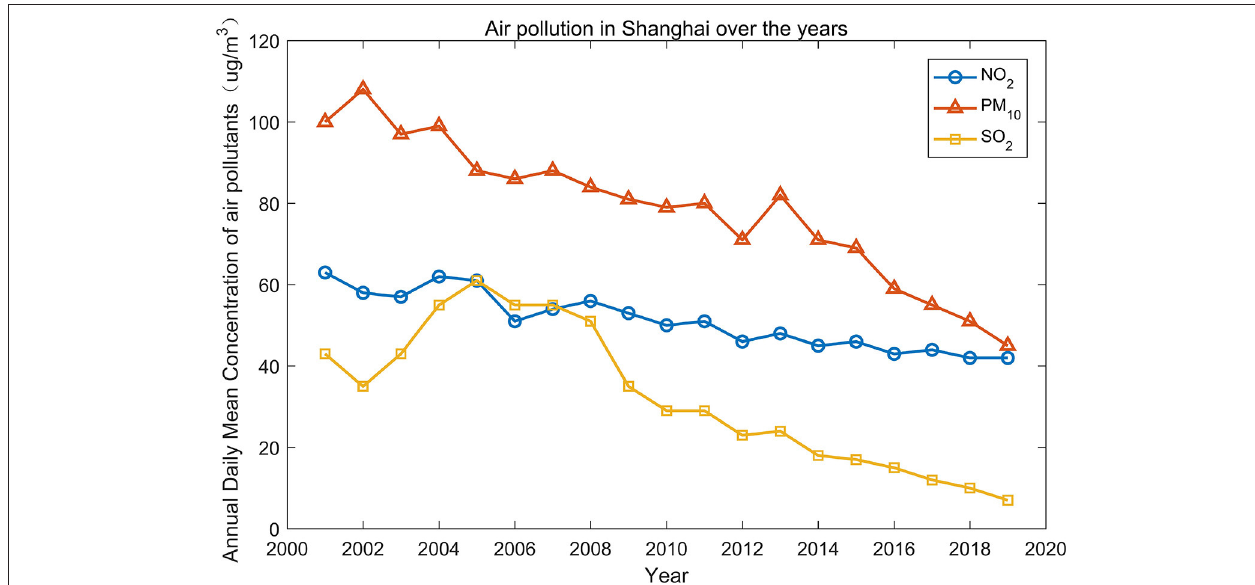
FIGURE 2 | The annual mean concentrations of air pollutants in Shanghai, 2001–2019.